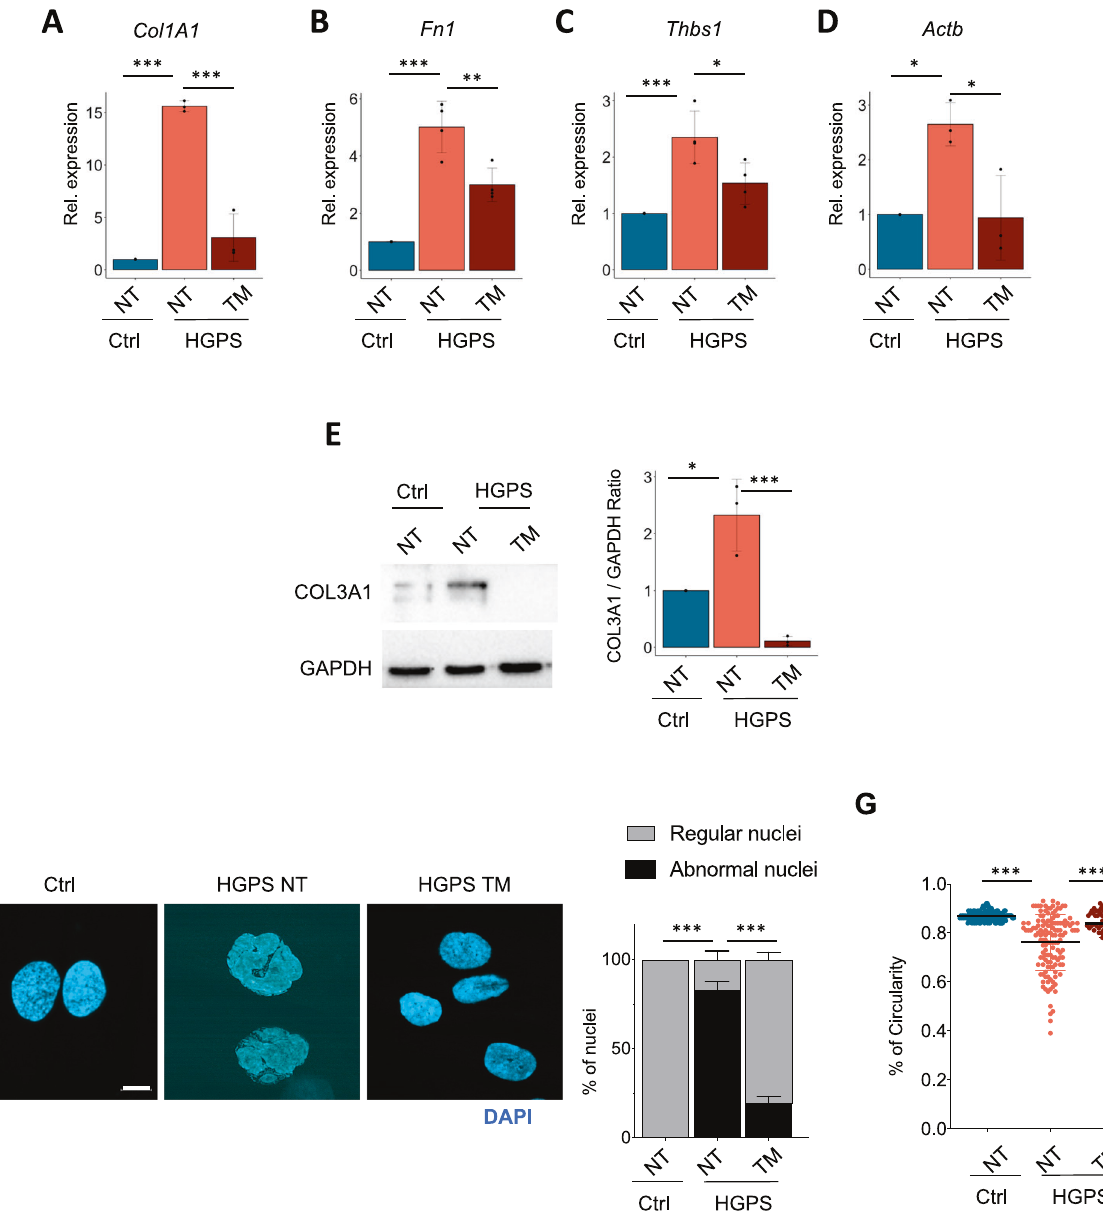
Fig. 4 TM5441 treatment restores normal nuclear shape and reduces the accumulation of fi brosis. A – D qRT-PCR for Col1A1 ( n = 3), Fn1 ( n = 4), Thbs1 ( n = 4) and Actb ( n = 3) in control (Ctrl) and 8YO HGPS untreated and treated with TM5441 (TM). E Cropped immunoblot for Collagen3A1 (COL3A1) and GAPDH in 8YO HGPS untreated and treated with TM5441(TM) and age-matched control (Ctrl) cells. Plot represents COL3A1/GAPDH ratio based on the average for each experimental point, ( n = 3). F Representative images of immuno fl uorescence for DAPI (blue) in 8YO HGPS fi broblasts untreated (NT) or treated with TM5441 (TM) and age-matched control (Ctrl). Scale bar 30 μ M. Quanti fi cation of regular and abnormal nuclei in control (Ctrl) and 8YO HGPS cells untreated (NT) or treated with TM5441 (TM), ( n = 3). G Quanti fi cation of nuclear circularity in control (Ctrl) and 8Y HGPS cells untreated (NT) or treated with TM5441